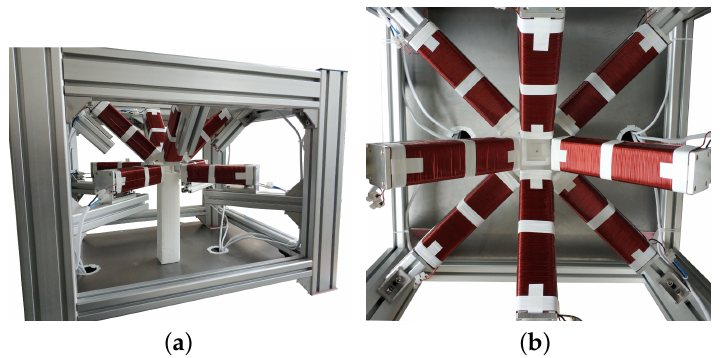
Figure 2. The proposed Rectmag3D prototype designed and constructed at Harbin Institute of Technology, Shenzhen. ( a ) Main mechanical structure of the system; ( b ) Top view of the main